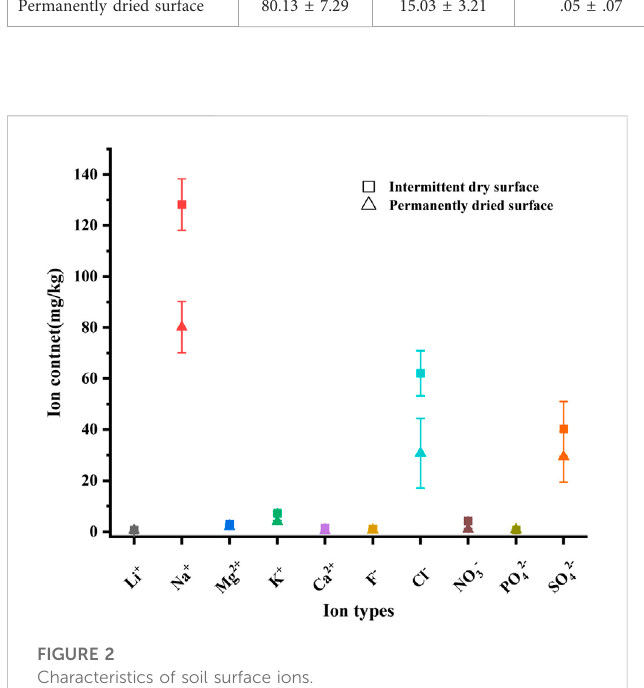
FIGURE 2 Characteristics of soil surface